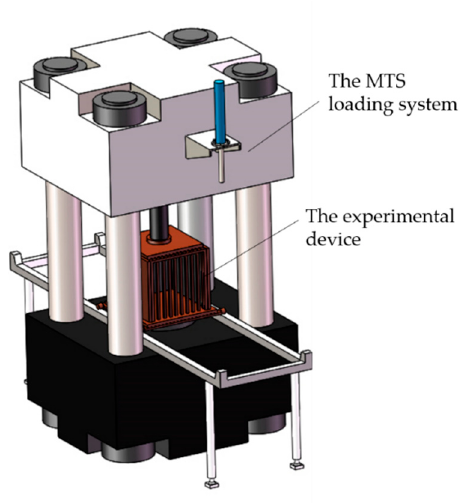
Figure 3. The MTS hydraulic servo loading system.